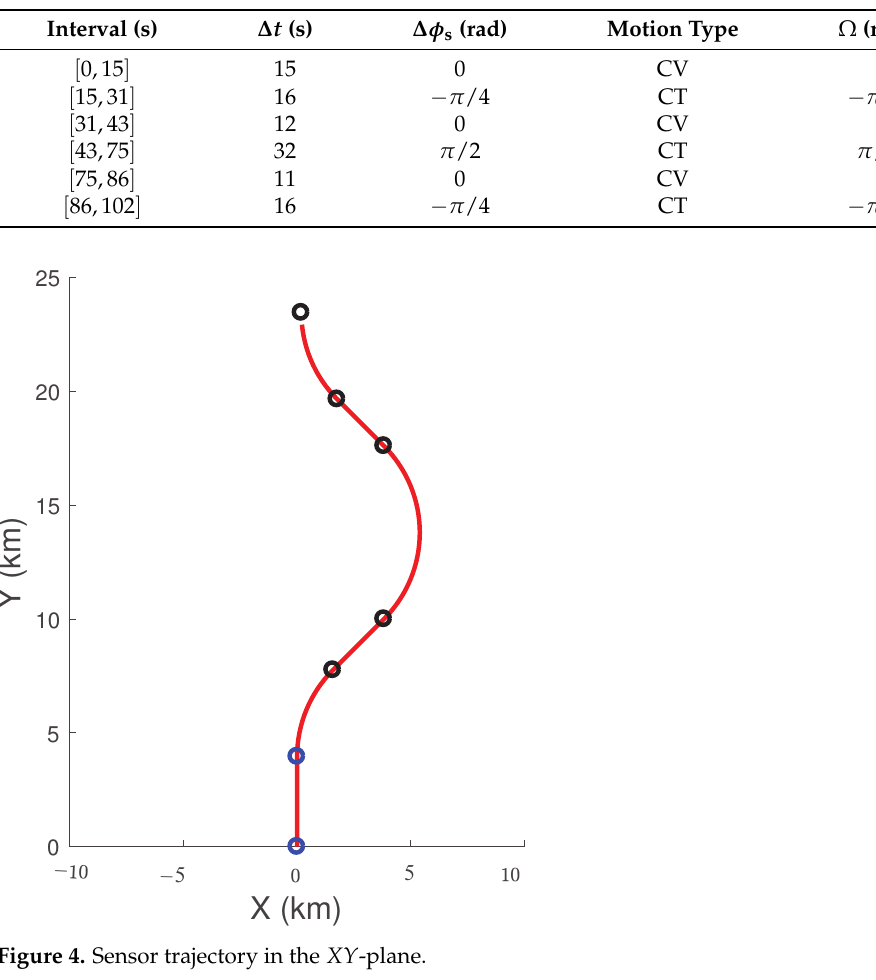
Table 3. Motion profile of the sensor.